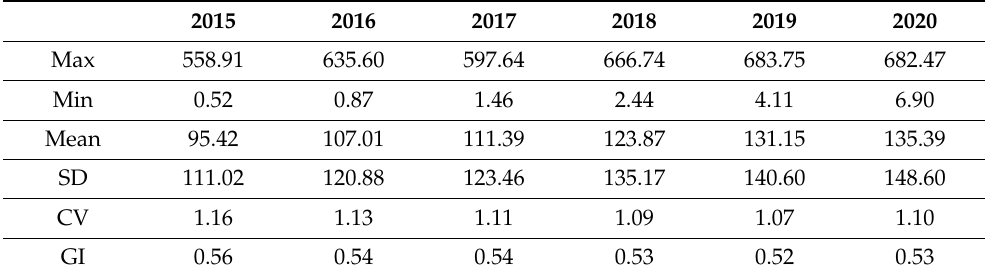
Table 5. Spatial heterogeneity analysis of night light extended vitality index in